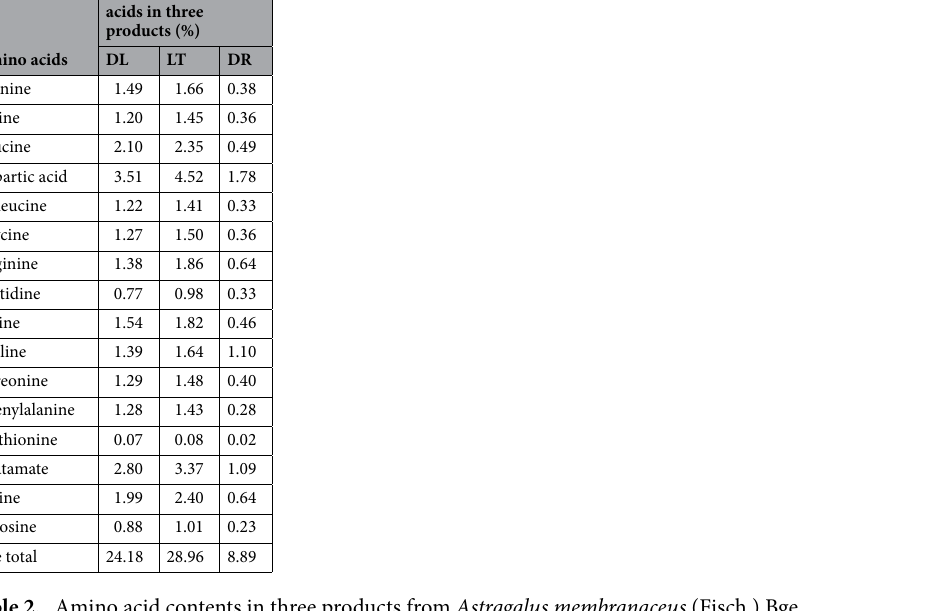
Table 2. Amino acid contents in three products from Astragalus membranaceus (Fisch.)